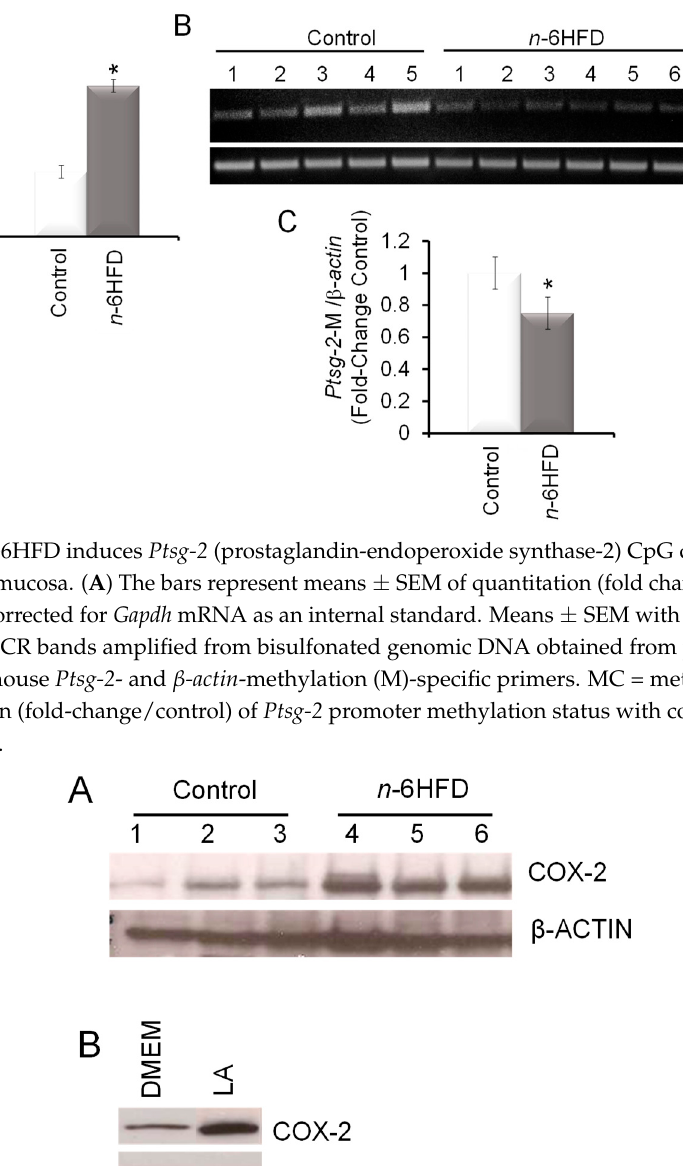
Figure 4. An n -6HFD induces COX-2 expression in mouse colonic mucosa. ( A ) The bands are representative immunocomplexes for COX-2 and internal control β -ACTIN in colonic mucosa of mice fed a control or an n -6HFD. ( B ) The bands are representative control immunocomplexes for COX-2 and internal control β -ACTIN from two separate experiments performed in triplicate in cell lysates of human fetal cells (FHC) cultured in control DMEM (Dulbecco’s Modified Eagle’s Medium) or DMEM plus LA (linoleic acid) (75 μ M) for 72 h.